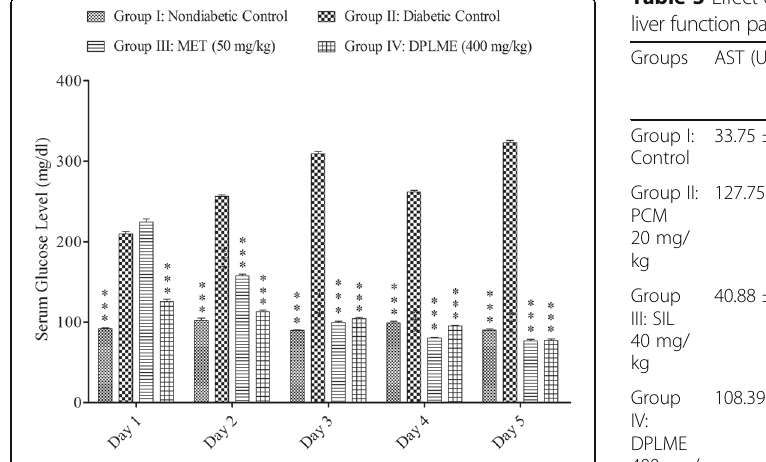
Fig. 2 Effects of D. pentandra leaf methanolic extract on blood glucose levels in non-diabetic and diabetic rats. Values are expressed as mean± SEM ( n =6). *** p <0.001 denotes statistically very significant result for a group when it was compared with the control group (Group II)